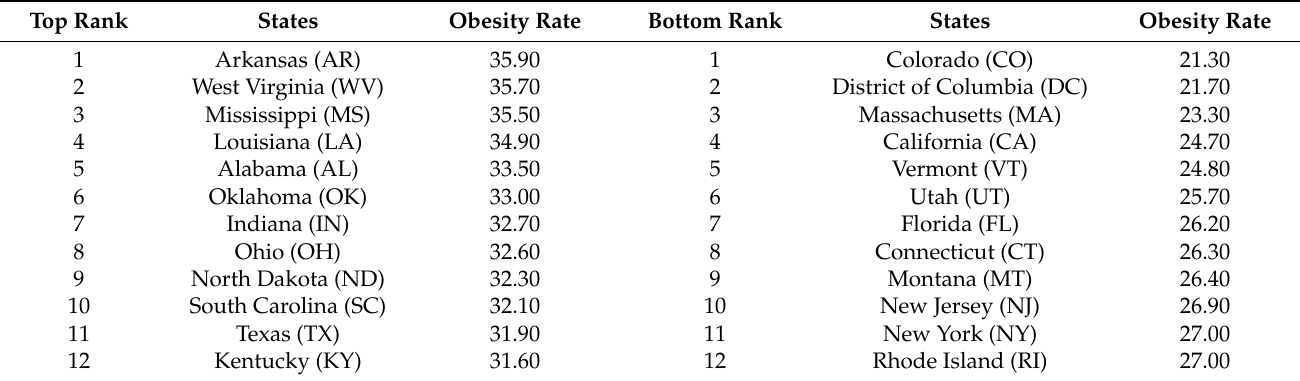
Figure 1. ( a ) Adult obesity rates by U.S. states, 2014, with state abbreviations. Selected ranks (1, 2, 3, 4) are identified (black squares: high-value ranks; white squares: low-value ranks); ( b ) Clusters identified by local Moran; ( c ) Clusters identified by local G-statistic. Table 1. Twelve states with the highest and lowest adult obesity rates. Data from Levi et al. (2014) The State of Obesity: Better Policies for a Healthier America 2014.